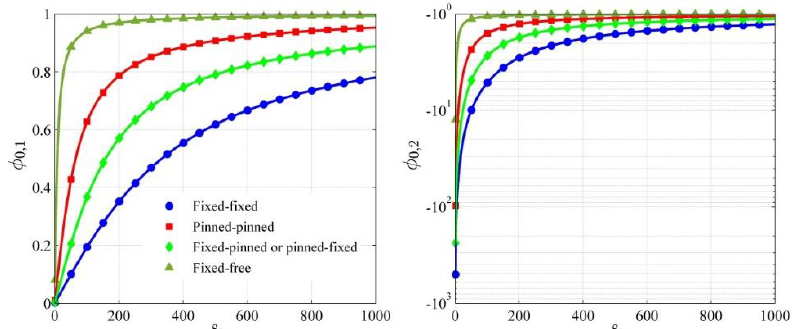
Figure 6. Mode amplitude ratios in two sub-modes corresponding to the 1st basic mode versus contact stiffness ratio ( s e ) for different boundary conditions when s m = 1 and s k = 2.